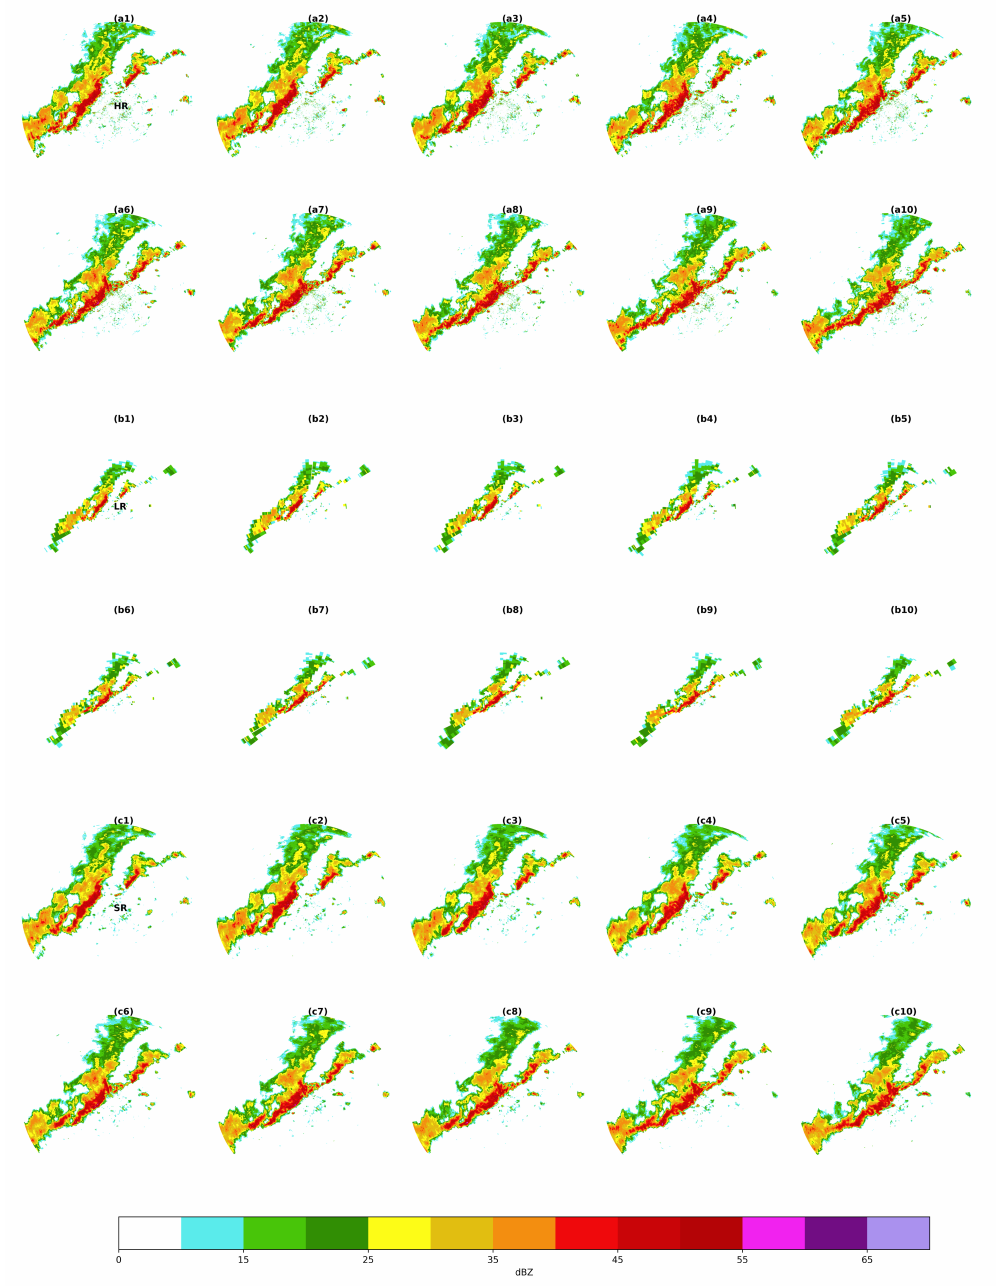
Figure A2. Precipitation data on the scaling factor ×